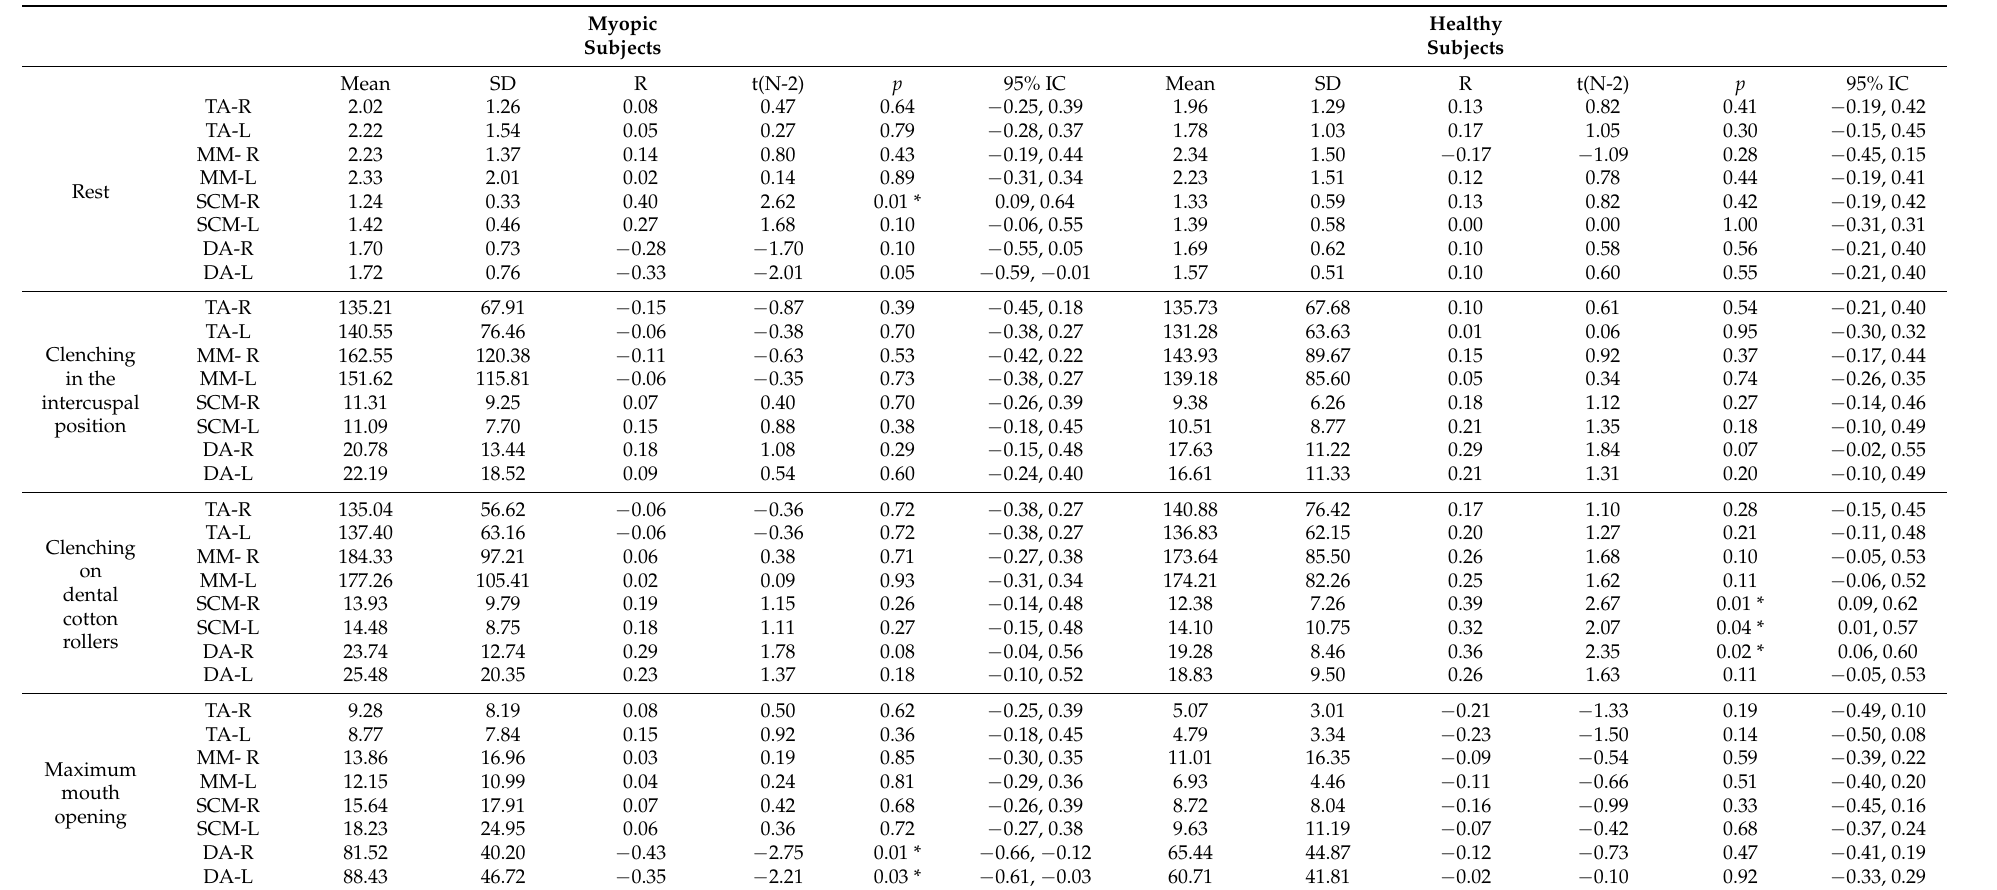
Table 4. Summary of myopia subjects’ and health subjects’ results of the closed eyes